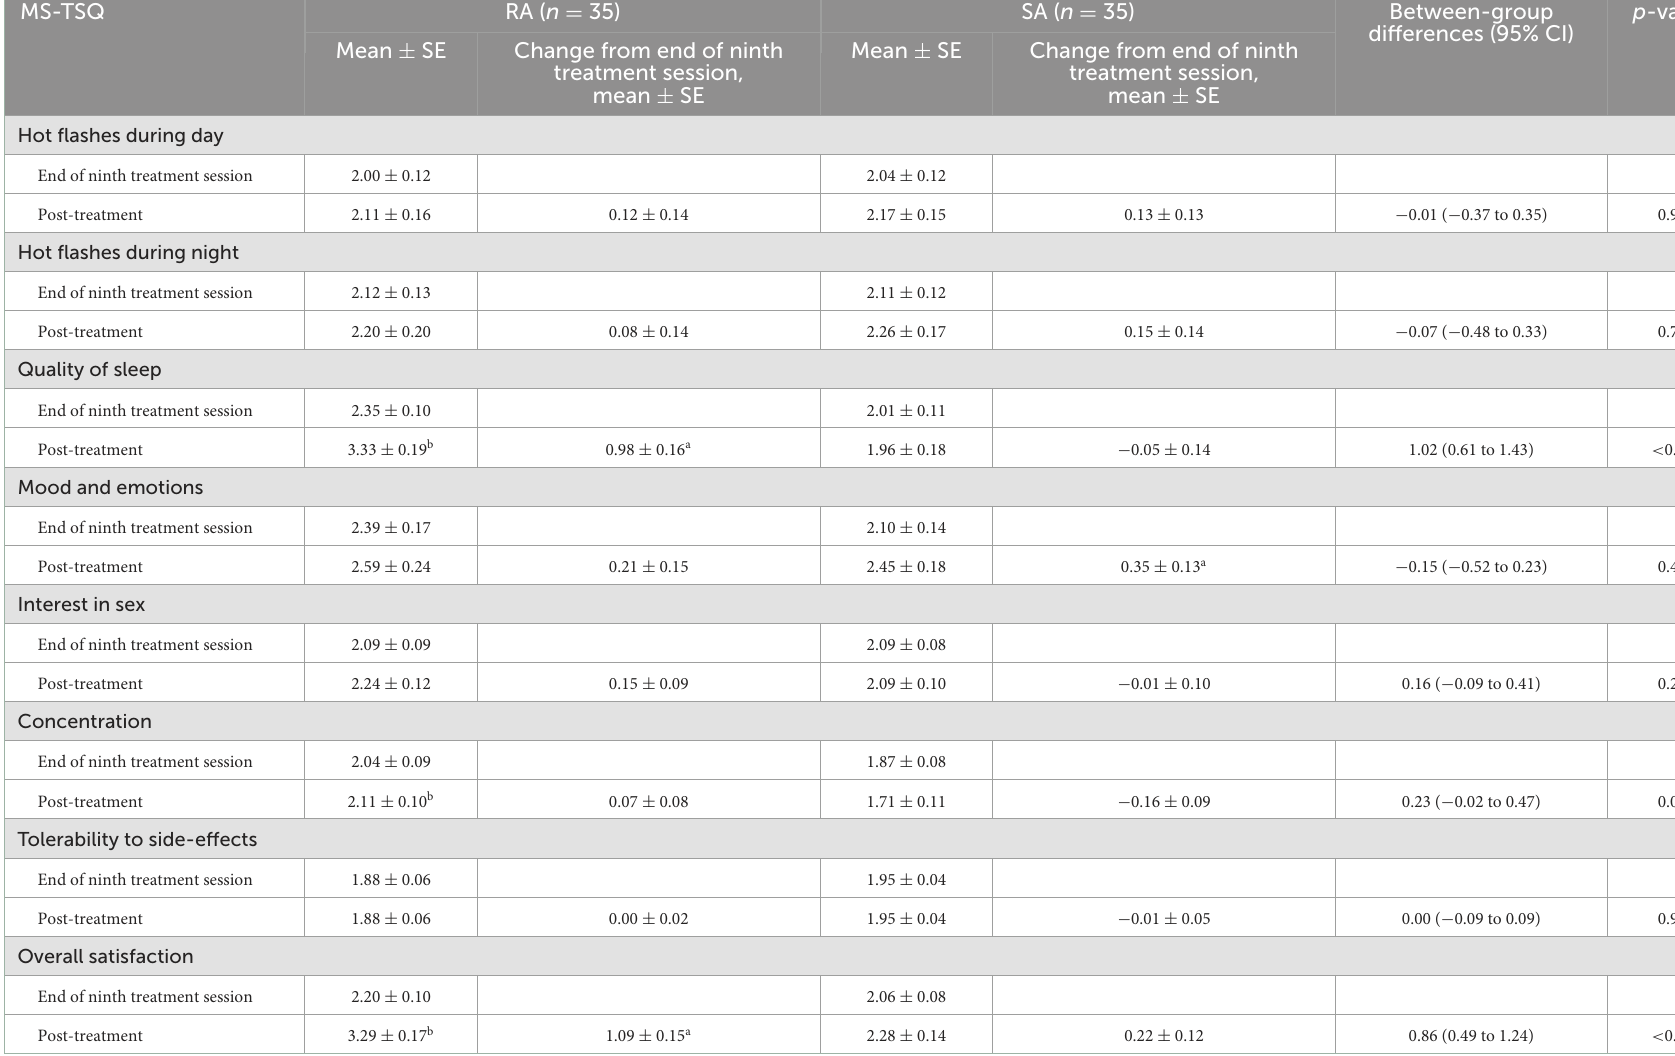
TABLE 12 MS-TSQ outcome across trial time-points (ITT dataset, participants = 70). MS-TSQ RA ( n = 35) SA ( n = 35) Between-group Mean ± SE Change from end of ninth Mean ± treatment session,